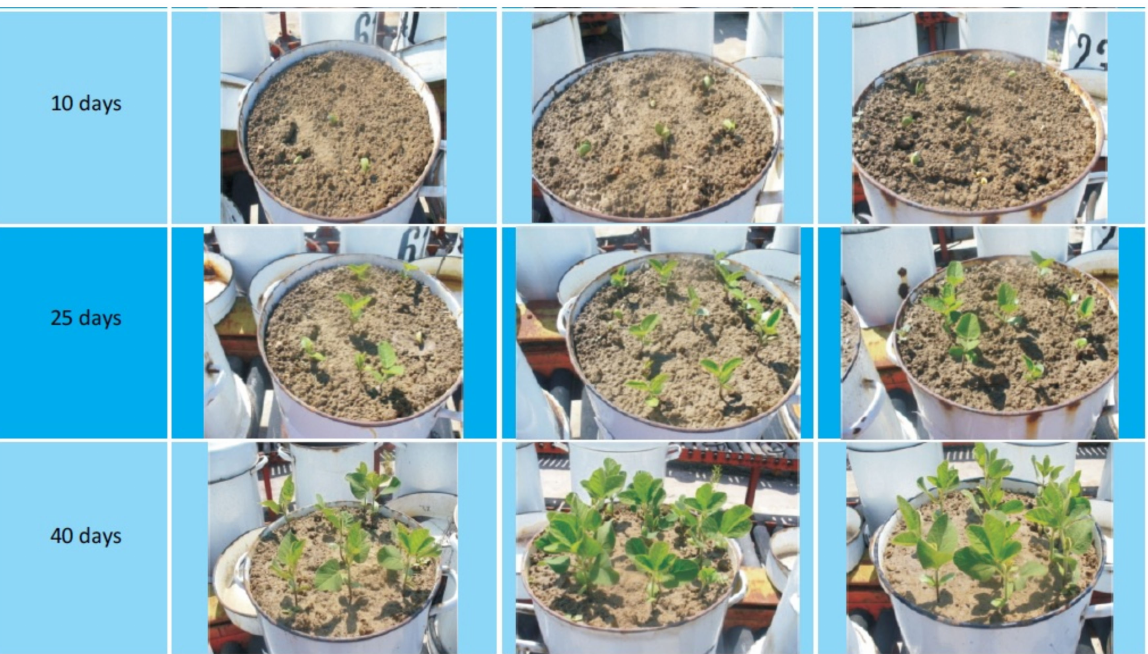
Figure 5. Soybean growth comparison (left—no fertilizer; middle—10 kg collagen NPK fertilizer/m 2 ; right—20 kg collagen NPKfertilizer/m 2 )